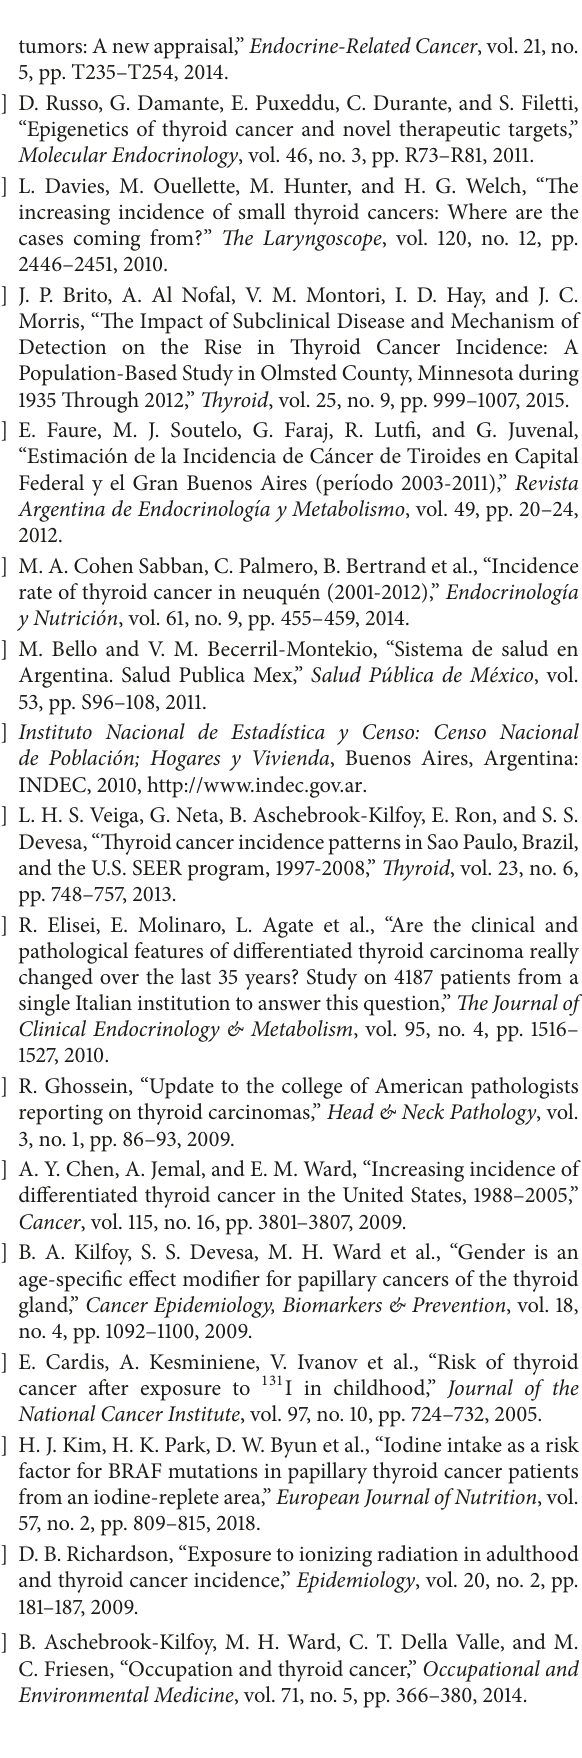
Table describing distribution of patients in categories and subcategories of methods of diagnosis of thyroid